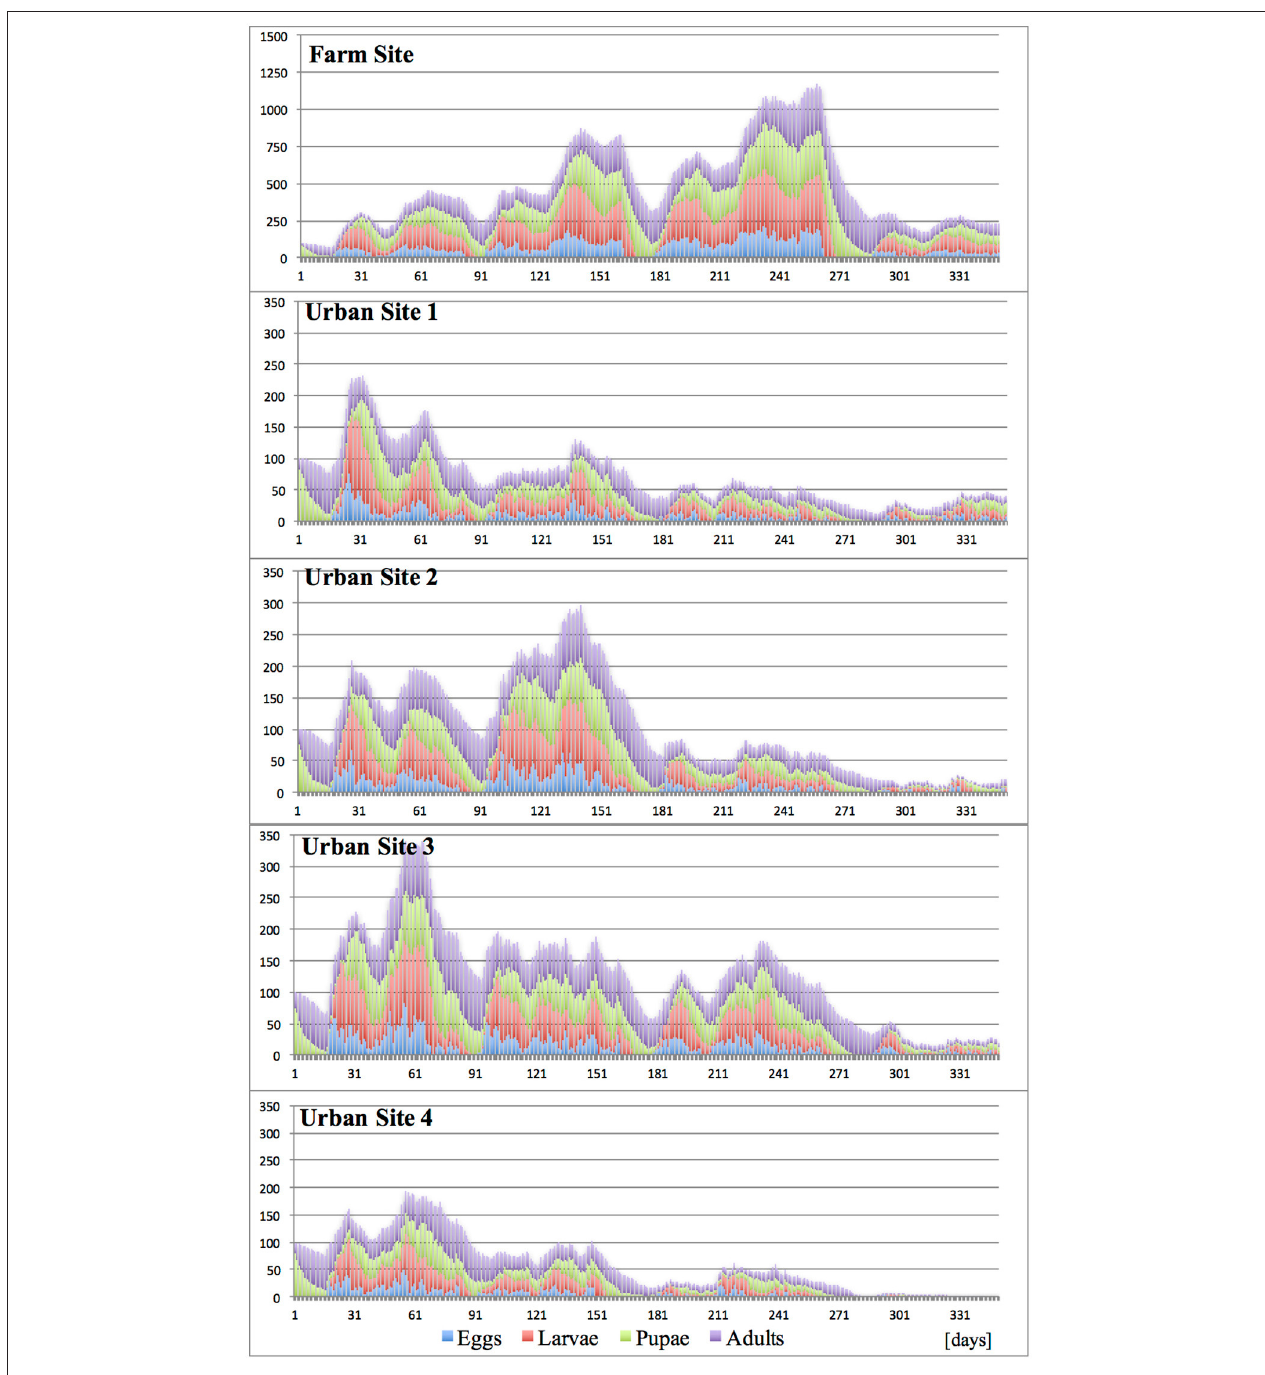
FIGURE 7 | Effects of site fragmentation on propagule development at constant temperature 30 ◦